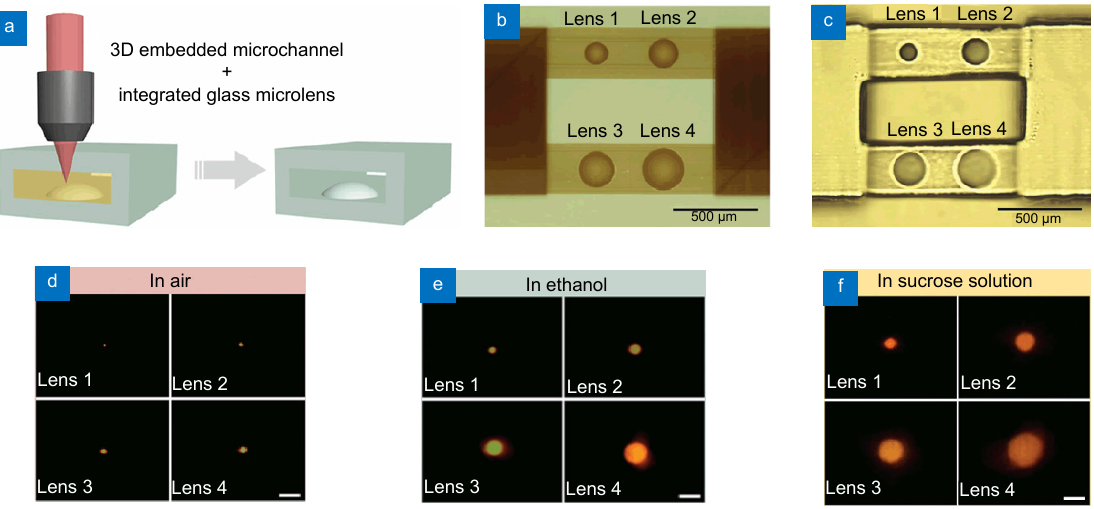
Fig. 4 | 3D optofluidic microlens integrated in microchannels. ( a ) Schematic of fabrication process. Optical images of microlens in microchannels ( b ) after laser modification and ( c ) after complete formation. ( d–f ) Focusing properties of microlens in microchannels in air, ethanol and sucrose solution, respectively. Figure reproduced from (a–f) ref. 80 , WILEY-VCH Verlag GmbH & Co. KGaA,